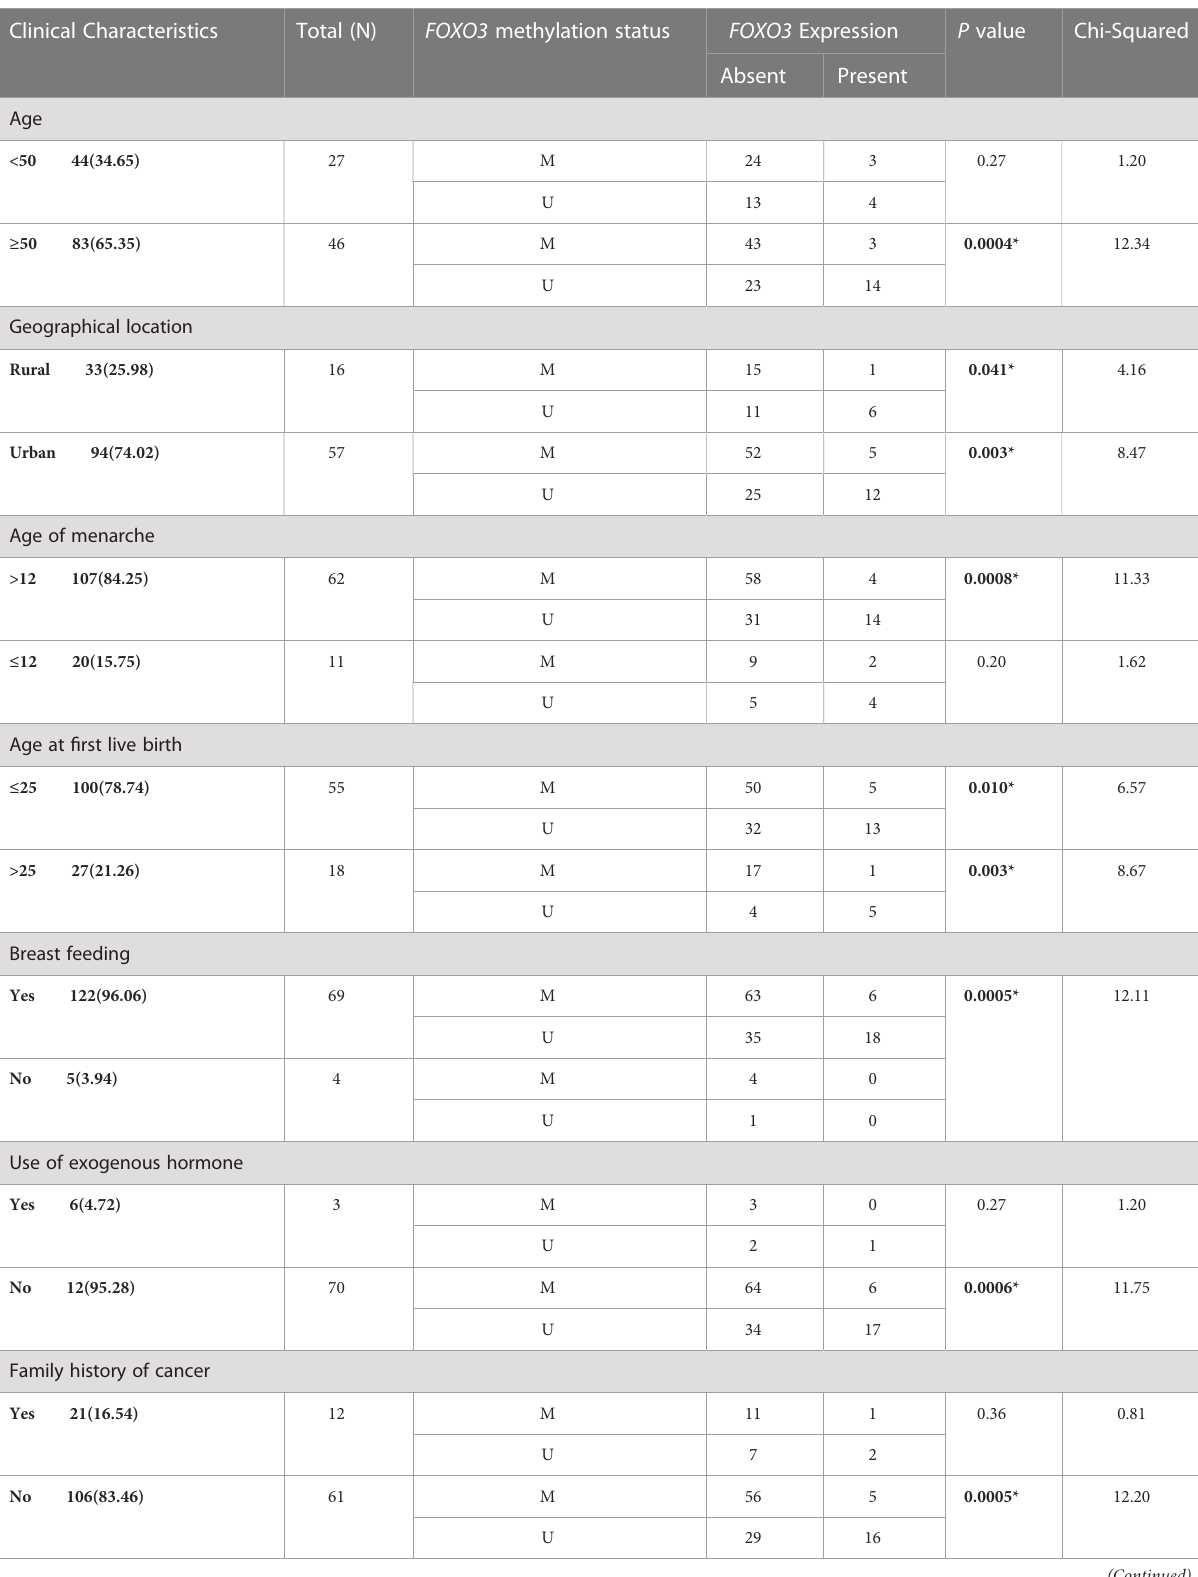
TABLE 7 Correlation analysis between FOXO3 methylation and FOXO3 protein expression in strati fi cation by various clinical characteristics of Breast cancer patients from North India. Clinical